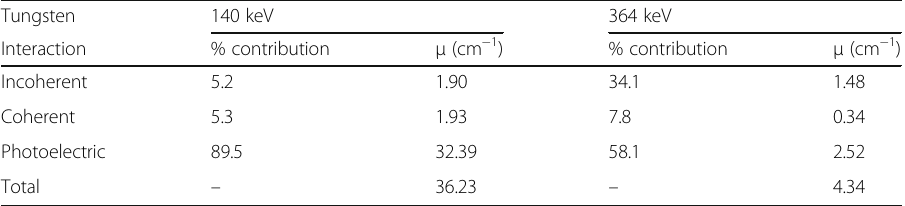
Table 3 Theoretical linear attenuation coefficients of tungsten at photopeak energies of Tc99m and I131 organised by interaction Tungsten 140 keV 364 keV Interaction % contribution